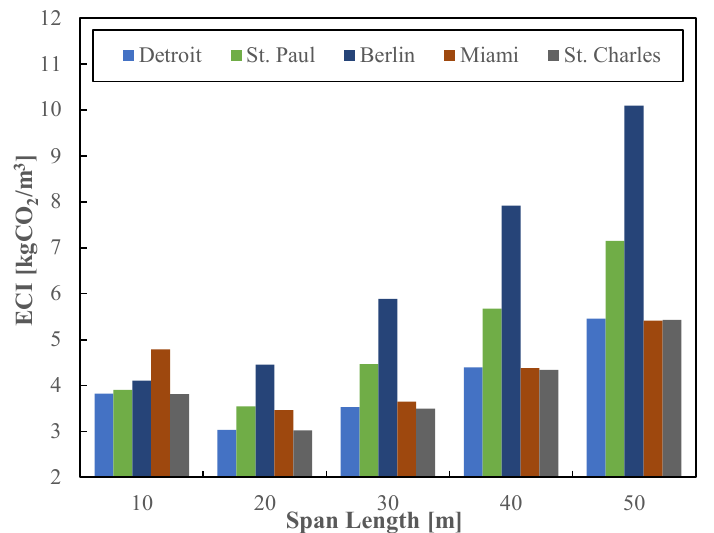
Figure 8. Average ECI achieved by Model 4 for different span lengths and loading